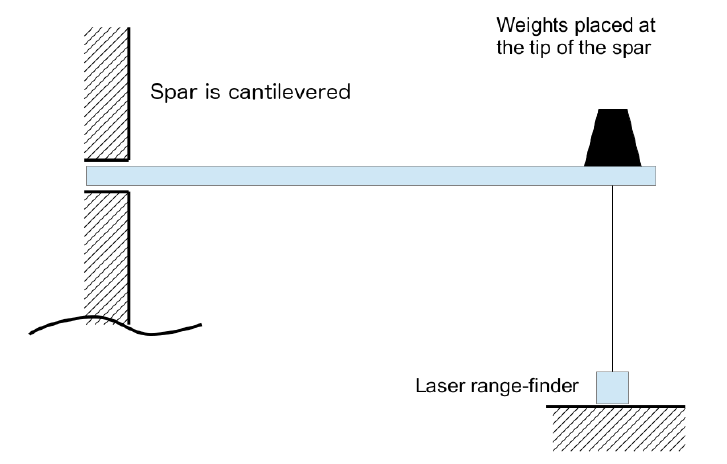
Figure 12. Wing spar experimental set-up. The wing spar model beam properties are also presented in Table